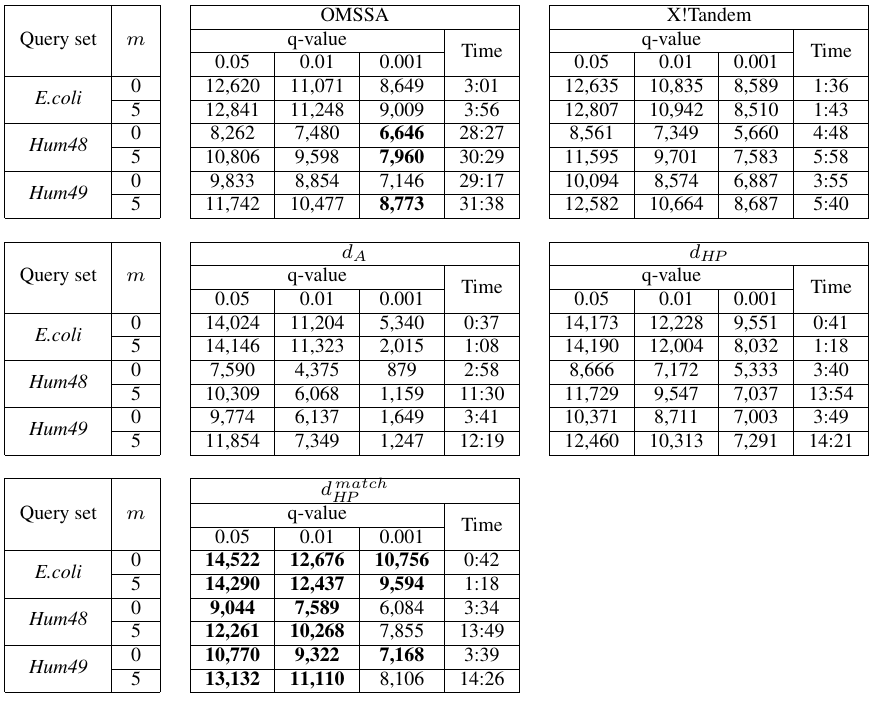
Table 1: Numbers of peptides identified by different engines and search times [min:sec]. When m = 0 , variable modifications were not searched. When m = 5 , five variable modifications were searched. A cell having the biggest number of identified peptides among all engines is